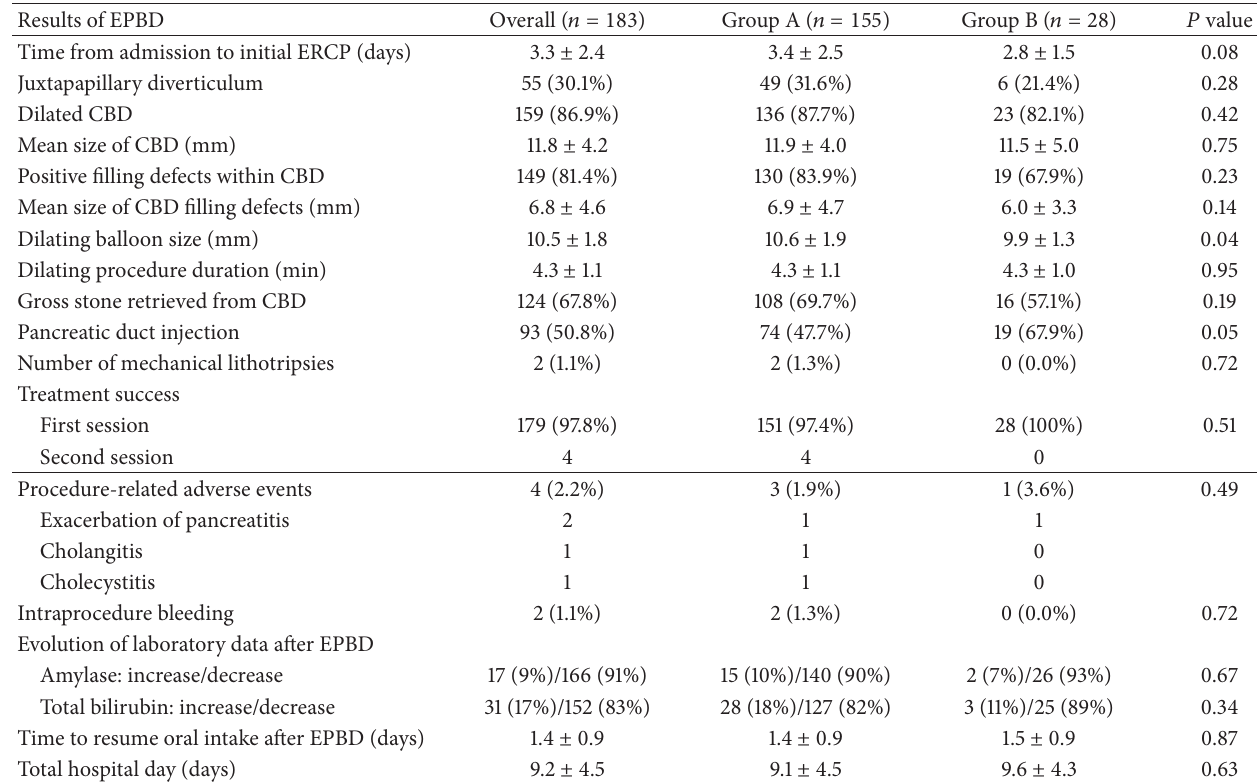
Table 2: Results of EPBD and clinical parameters in overall patients and comparisons between mild (A) and severe (B) degree of acute biliary pancreatitis.